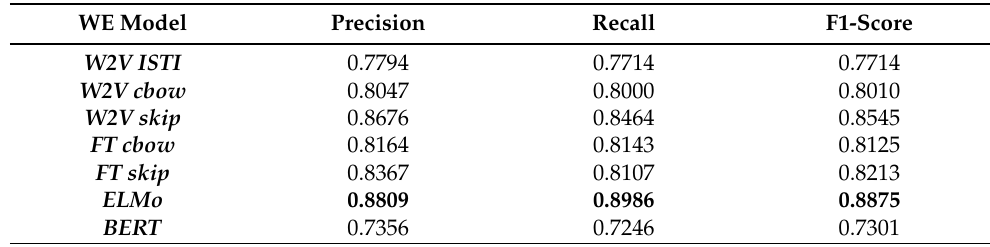
Table 10. Results in terms of F1-Score, precision and recall obtained by the DNN on the out-of-corpus test set, using different pretrained WE